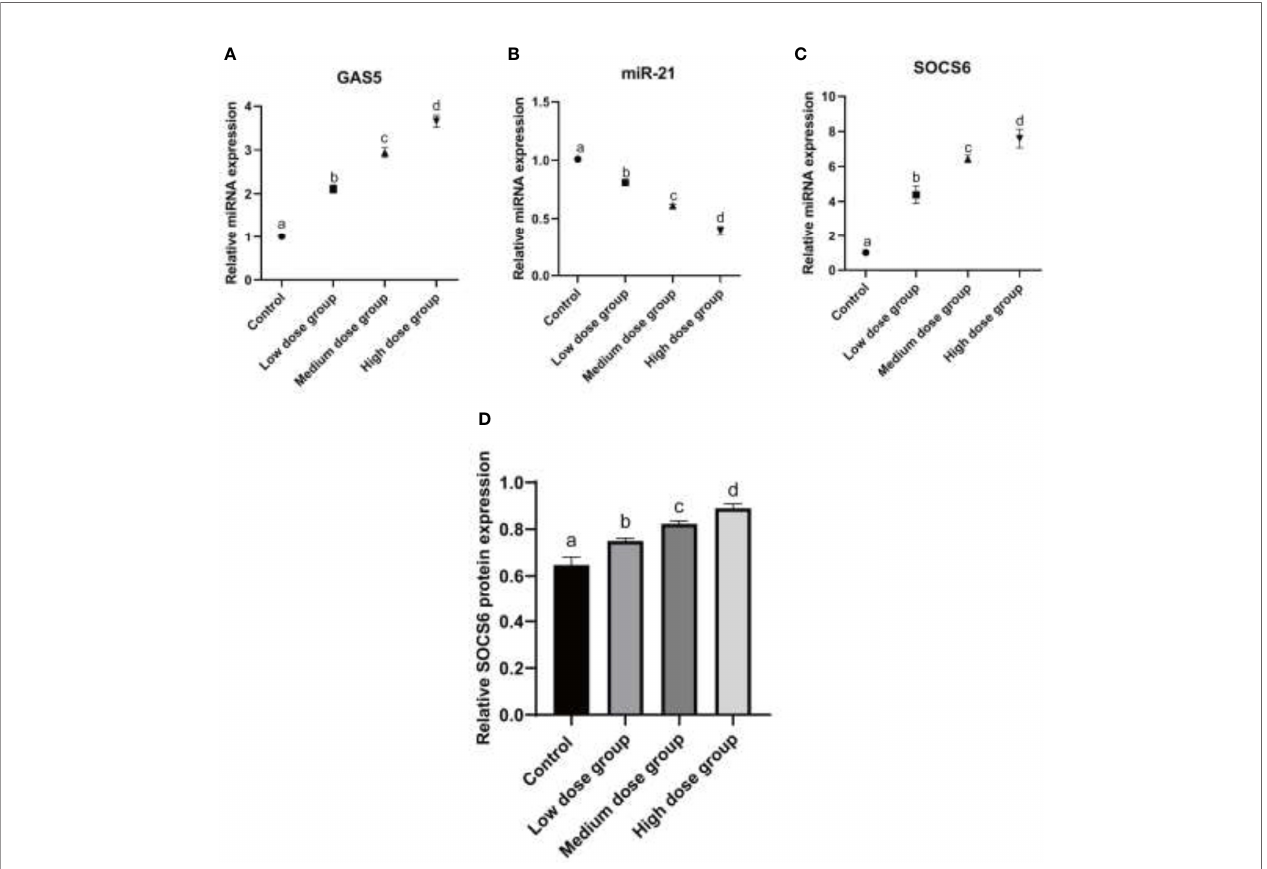
FIGURE 3 | Analysis of expression of GAS5/miR-21/SOCS6 in RAW264.7 treated with MIP. (A) Relative mRNA expression analysis of GAS5 at 24 h treated by different concentrations of MIP. (B) Relative mRNA expression analysis of miR-21 at 24 h treated by different concentrations of MIP. (C) Relative mRNA expression analysis of SOCS6 at 24 h treated by different concentrations of MIP. (D) Relative protein expression of SOCS6 was detected by WB. The signi fi cant differences were marked by the alphabetic notation (a – d) by using ANOVA. In the control and different concentration treatment groups, the control is marked with the letter a; in the low-dose group, an average that is signi fi cantly different from it is marked with the letter b, otherwise, letter a and continuously marked with letters c and d.